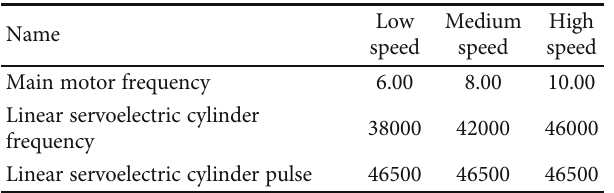
Figure 6: Position of the bionic mechanical foot markers. Table 2: Speed parameters of the actuator on the bionic mechanical foot.